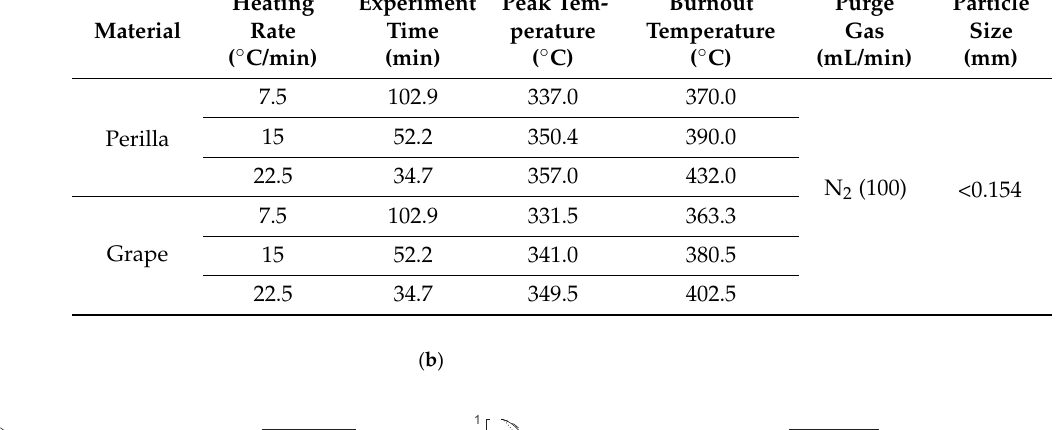
Table 4. Thermogravimetric analysis results.